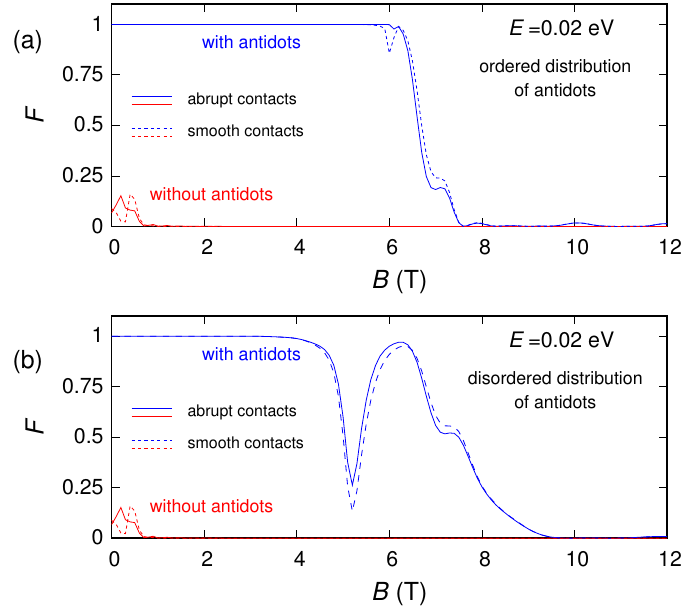
Figure 7. Fano factor of the graphene ribbon as a function of the orthogonal magnetic field, obtained for E = 0.02 eV in the presence of an ordered (panel ( a )) and a disordered (panel ( b )) distribution of antidots, compared with the Fano factor of the ribbon without antidots.